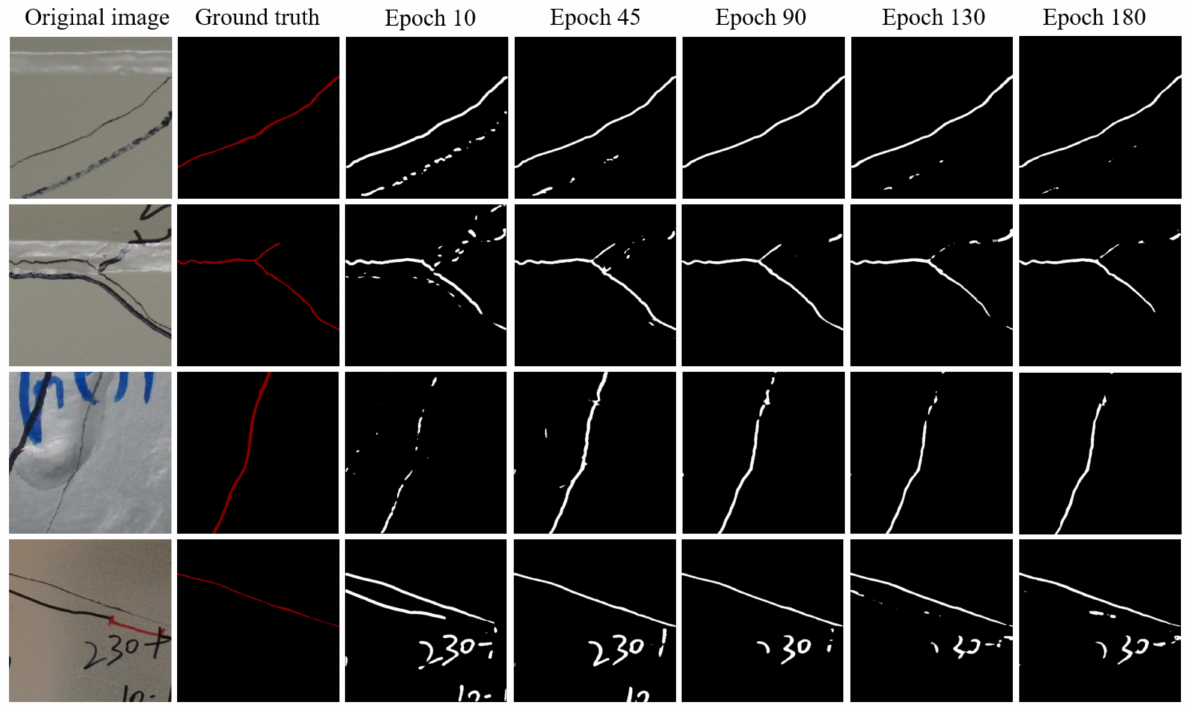
Figure 4. Predictions examples on the generated test dataset using the weights at different epochs: